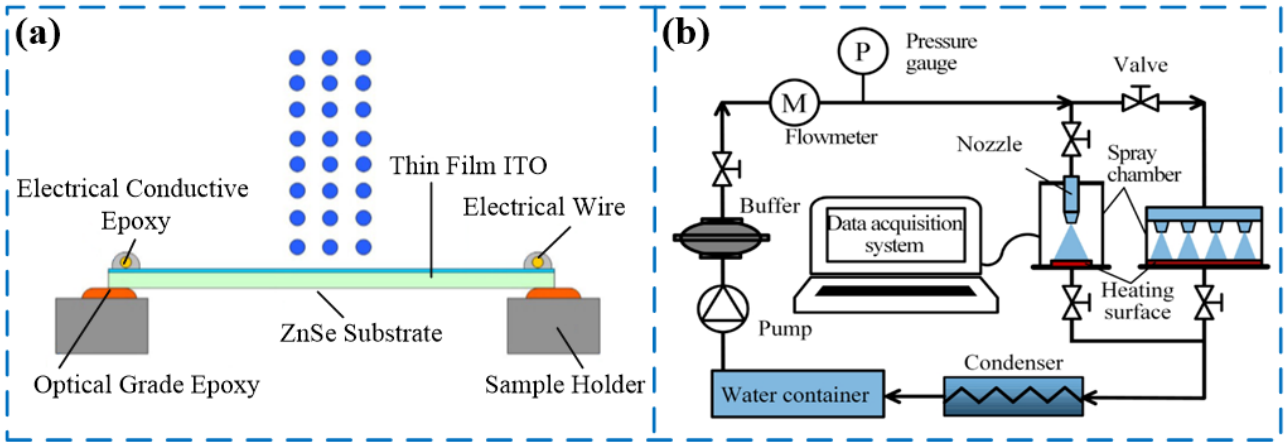
Figure 4. Spray cooling: ( a ) a zoomed view of heater assembly by Soriano et al. [77], reprinted with permission from Ref. [77]. Copyright 2014 Elsevier. ( b ) schematic diagram of experimental system by Chen et al. [79], reprinted with permission from Ref. [79]. Copyright 2017